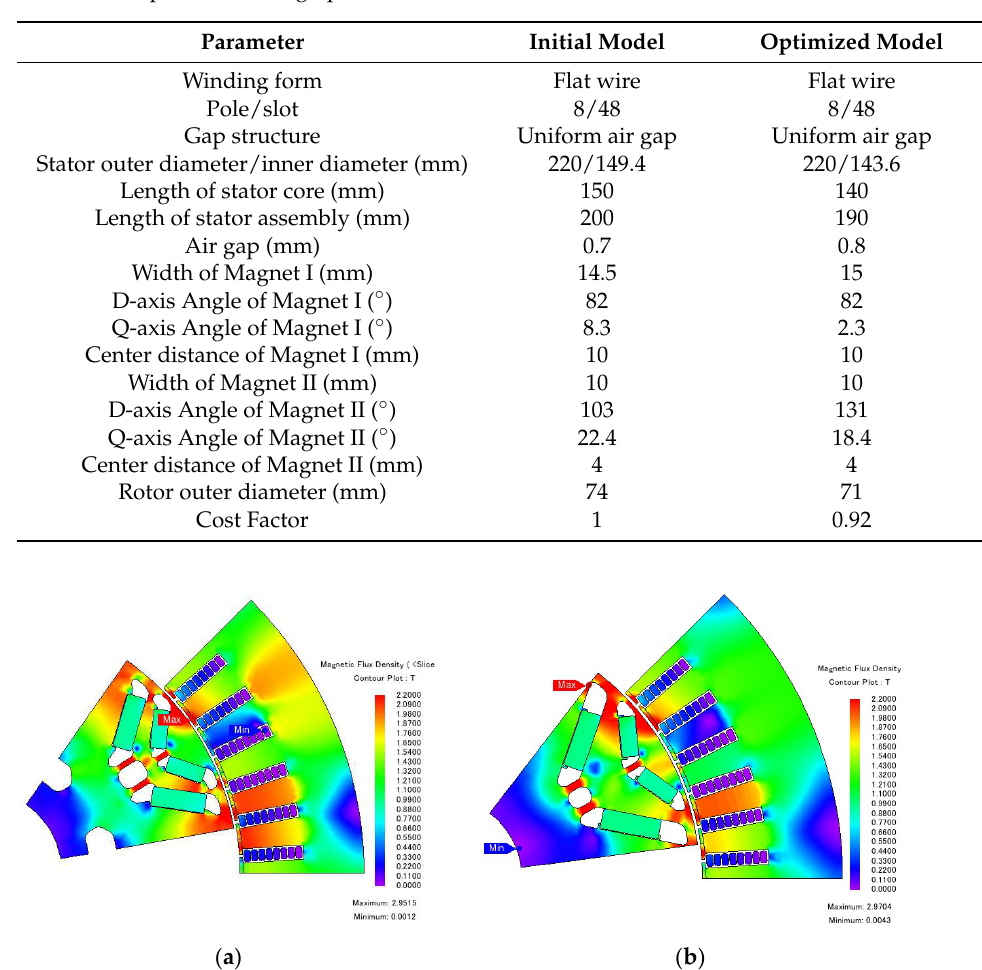
Table 6. Comparison of design parameters.